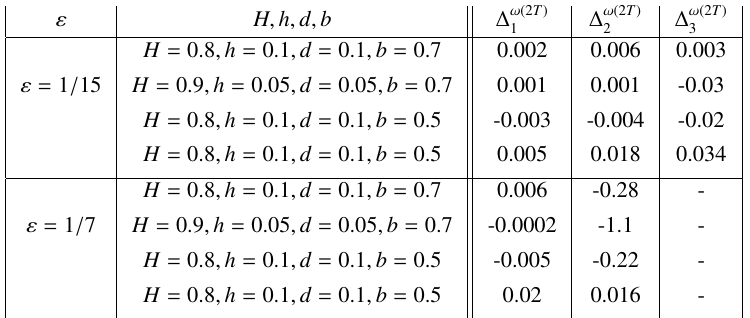
∆ ω (2 T ) ∆ ω (2 T ) 1 2 3 0.002 0.006 0.001 0.001 -0.003